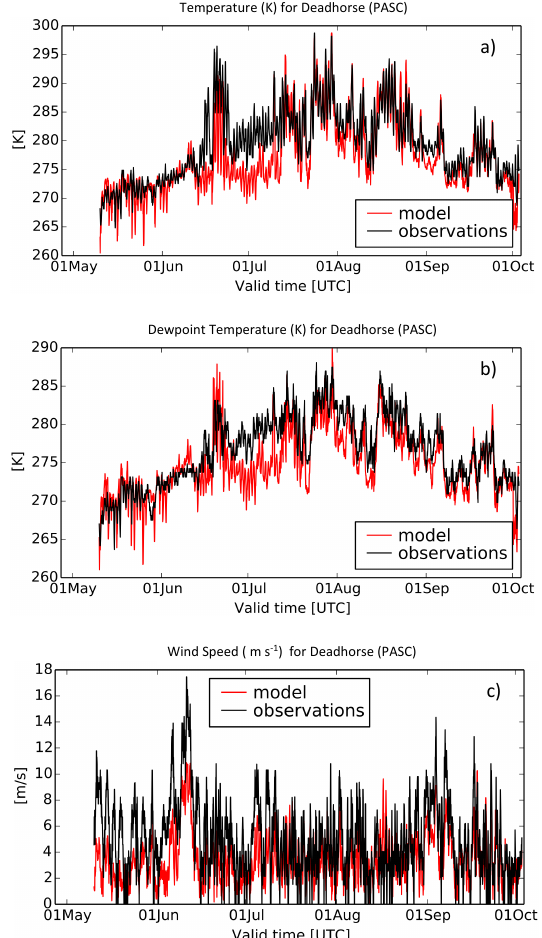
Figure 10. As in Fig. 8, but for Deadhorse, AK (station ID: PASC).